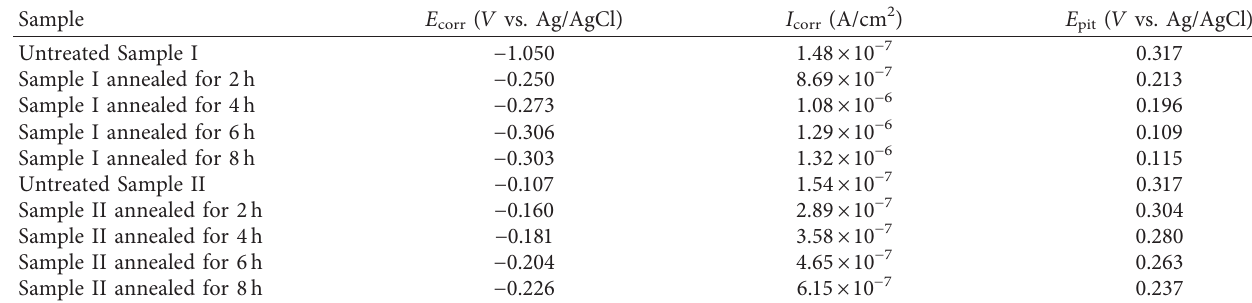
Table 2: Polarization curve fitting